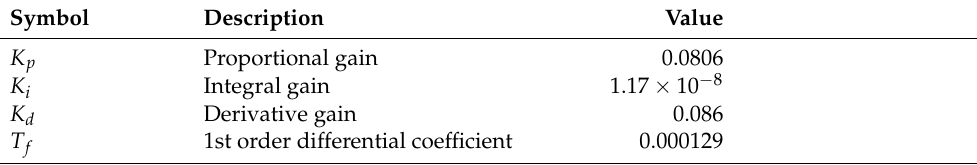
Table 8. Values of the optimized parameters for structure H ∞ synthesis for angular position